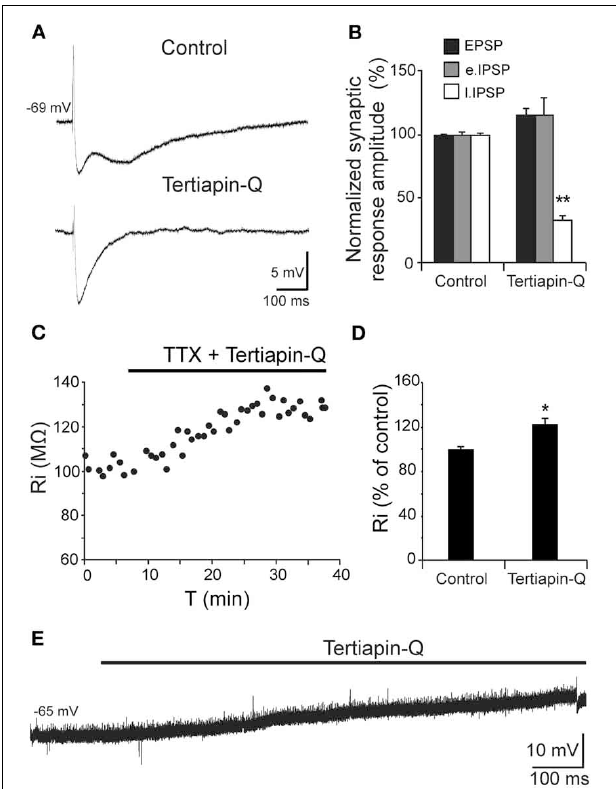
FIGURE 6 | Effects of the selective GirK channel antagonist tertiapin-Q on CA3 pyramidal neurons complex response to fimbria stimulation. (A) Selective blockade by tertiapin-Q of the late IPSP recorded in CA3 pyramidal neurons after fimbria stimulation. Superfusion of the GirK antagonist tertiapin-Q (0.5 μ M; selective blocker of GirK channels) selectively blocked the late IPSP but did not reduce the early IPSP that was elicited by fimbria stimulation. (B) Histograms with relative mean amplitude ( n = 5) of the different components of the complex synaptic response (EPSP; early, e.IPSP; and late, l.IPSP) 40min after tertiapin-Q perfusion. Significant differences were found for late IPSP. (C) Results of an experiment in another neuron designed to assess the postsynaptic effects of tertiapin-Q on Ri of CA3 pyramidal neurons. Perfusion of TTX ( n = 5; 1 μ M; voltage-dependent sodium channel blocker) blocked afferent neurotransmission and therefore any effect of tertiapin-Q took place at postsynaptic location. Note the significant Ri increase after 30min. (D) Histogram with mean values in percentage for Ri ( n = 6) after tertiapin-Q perfusion during 40min ( ∗ p < 0 . 05). (E) Effect of tertiapin-Q on CA3 pyramidal neurons membrane potential ( n = 5). Chart record shows